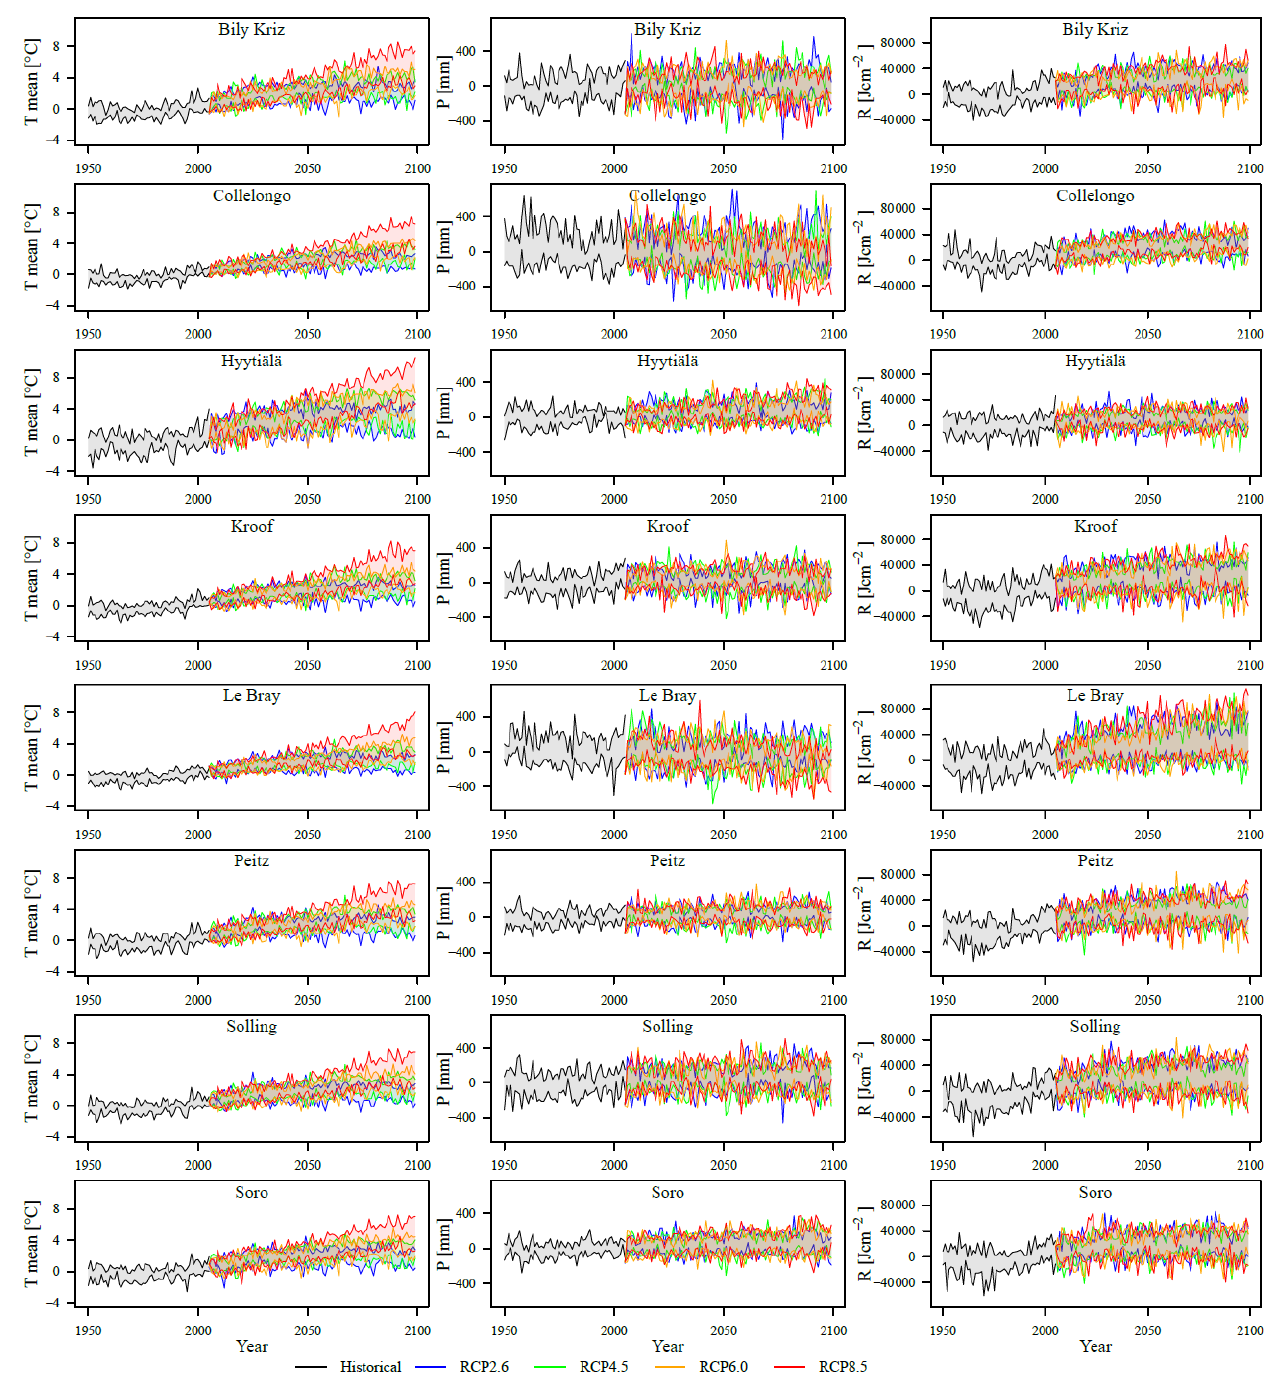
Figure 2. Change in mean annual temperature ( T mean), annual precipitation sum ( P ) and annual sum of global radiation ( R ) over the time period 1950–2099 relative to the 1980–2005 average for the ISIMIPFT scenarios. Please note that the two Solling sites have the same